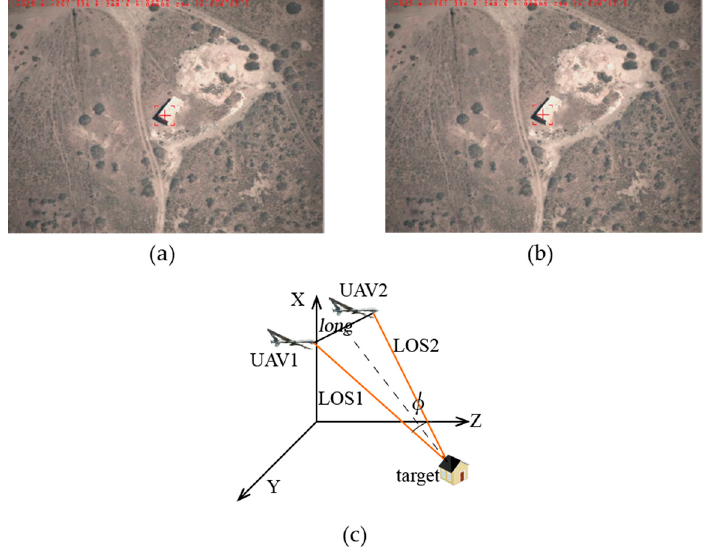
Figure 15. Feature position 3: ( a ) target detection by UAV1; ( b ) target detection by UAV2; and ( c ) positional relationship graph between the two UAVs and the target.